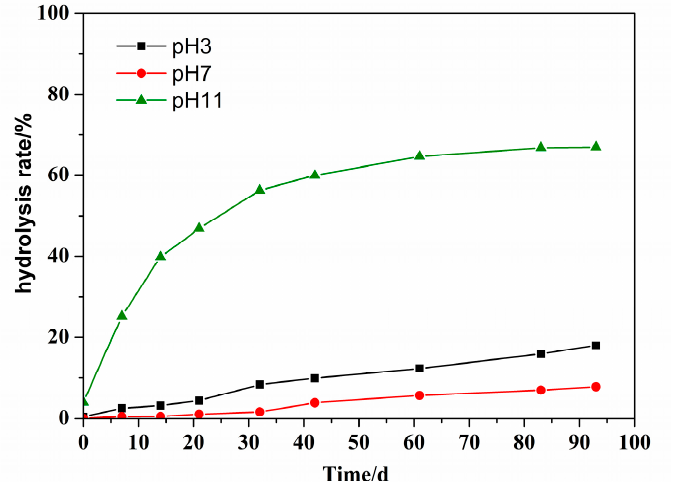
Figure 12. Effect of pH on the hydrolysis rate of PDMC solution.